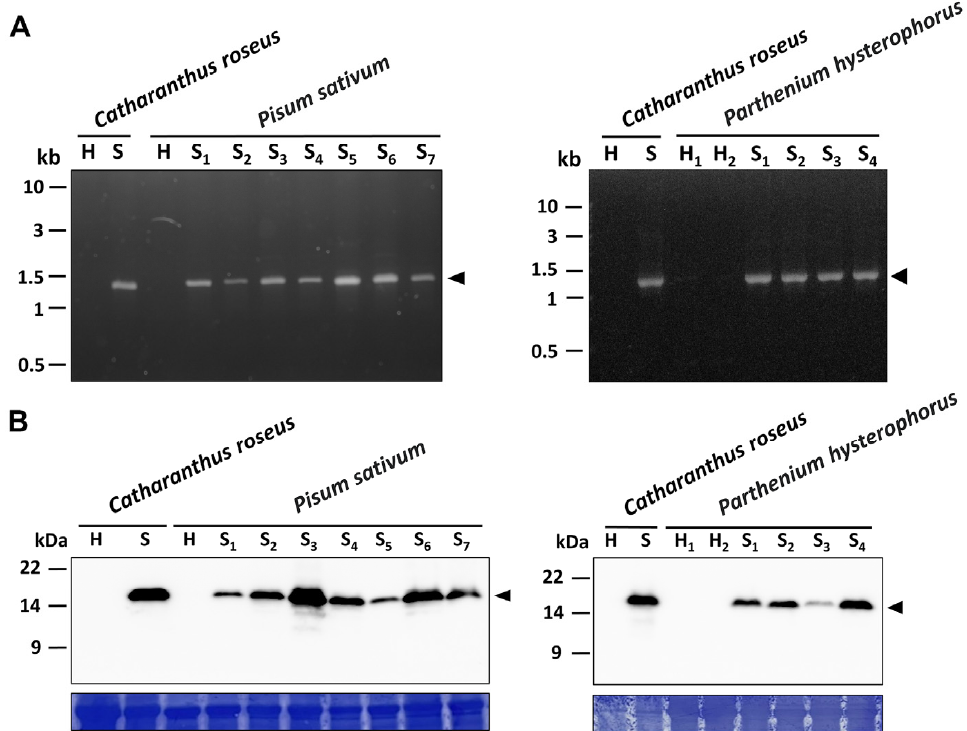
Figure 4. PCR and western blotting analyses of symptomatic Pisum sativum (green pea) and Parthe- nium hysterophorus (parthenium weed). ( A ) The 1.2 kb DNA fragment (arrowhead) of the 16S rRNA gene was amplified by PCR from symptomatic (S) samples and not from healthy-looking (H) ones. Catharanthus roseus infected by the 16SrII-V subgroup phytoplasma strain ( Echinacea purpurea witches’ broom, EpWB) was used as a positive control. ( B ) Western blotting analyses using polyclonal antibody against immunodominant membrane protein (Imp). The expected signal of 19 kDa (arrowhead) specific for Imp was detected in symptomatic samples and not in healthy-looking (H) ones (upper panel). The large subunit of Rubisco was visualized using Coomassie Brilliant Blue staining (lower panel) and was used as a loading control.